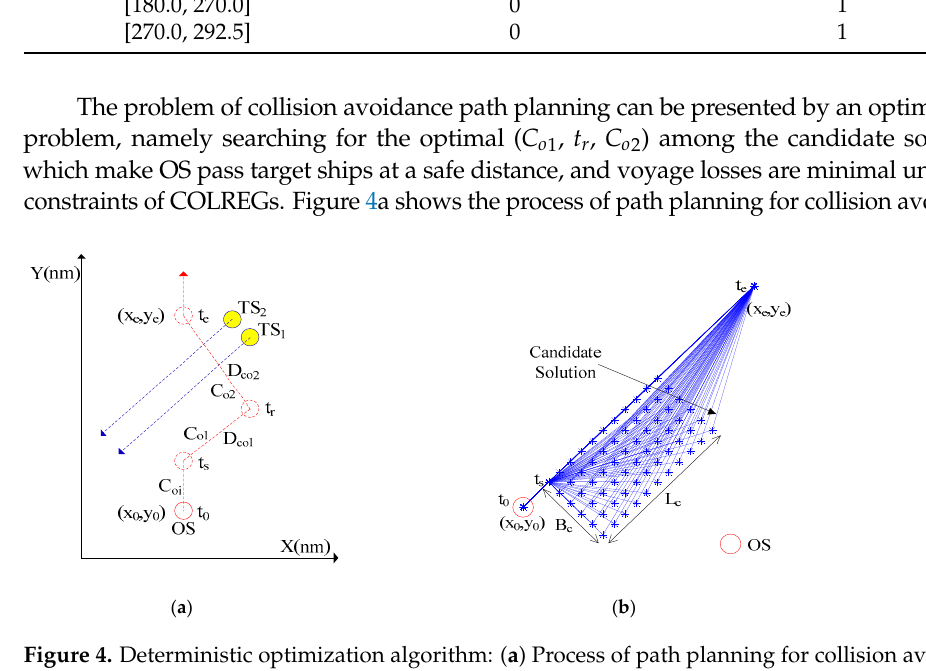
Algorithm 1: Pseudocode for collision avoidance path planning on the basis of DOA